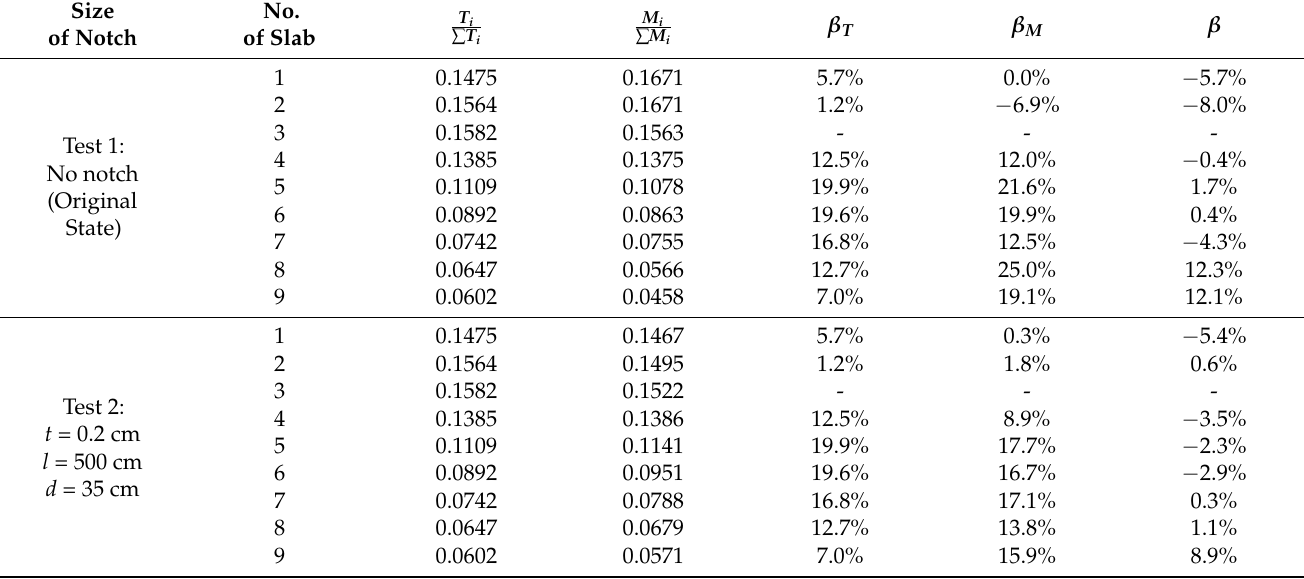
Table 3. Test conditions and